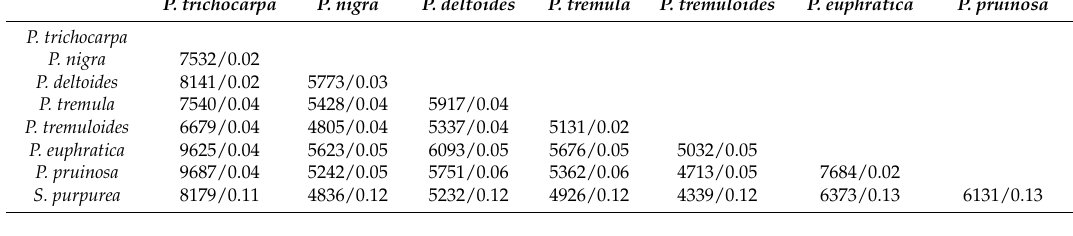
Table 2. Number and the rate of non-synonymous substitutions (Ks) peaks of orthologous genes in eight Salicaceae species.